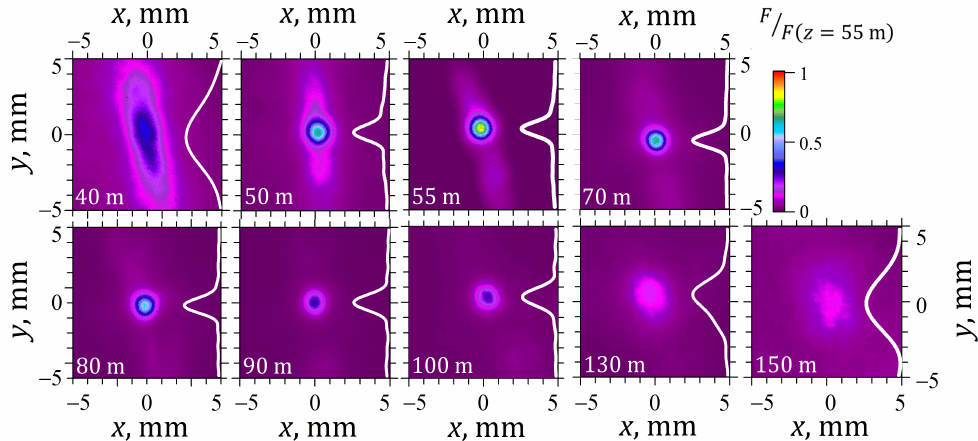
Figure 3. Experimentally measured transverse fluence distributions at different propagation dis- tances z . White curves show their slice at x = 0.